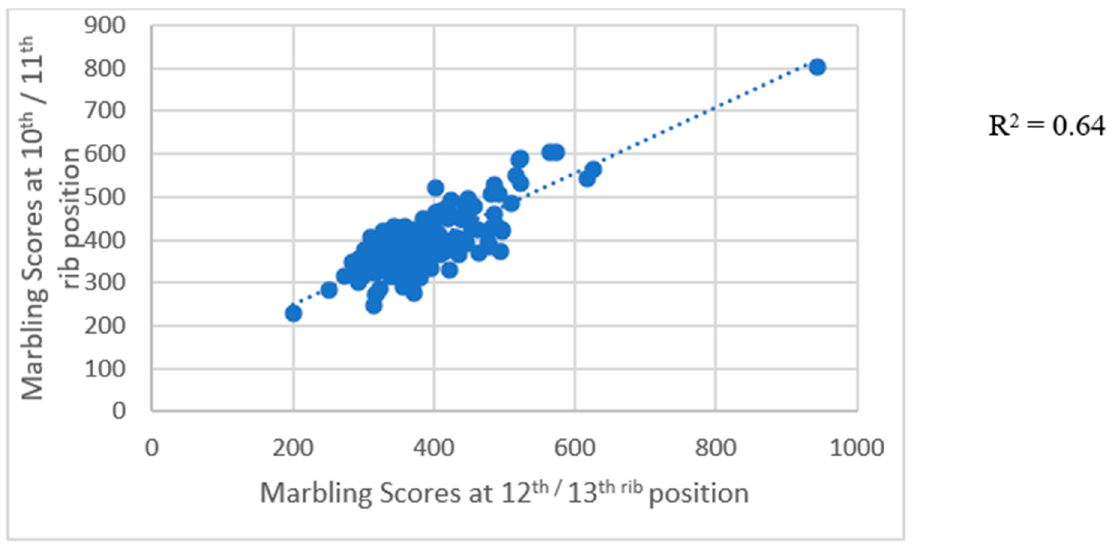
Figure 2. Distribution of marbling scores at the 10th/11th and the 12th/13th rib-eye position.